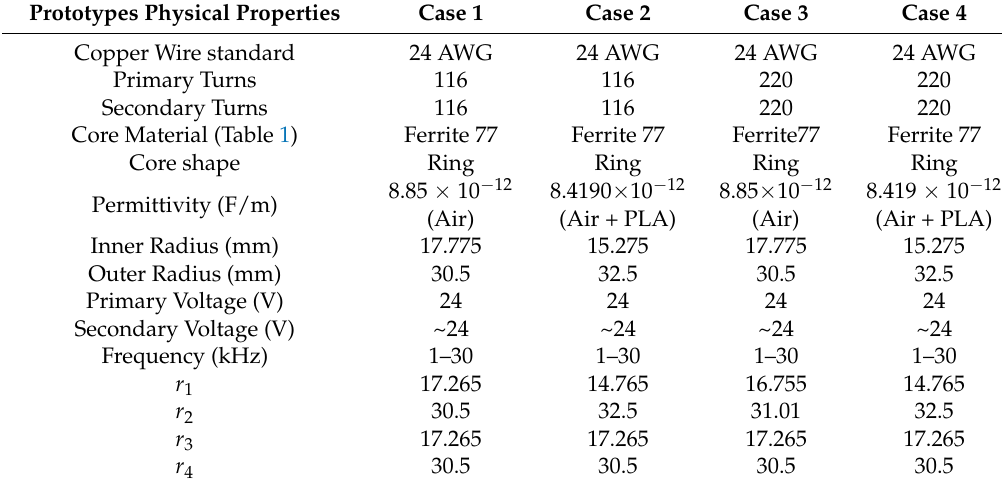
Table 4. Detailed parameters of the transformer prototypes. PLA—polylactic acid.